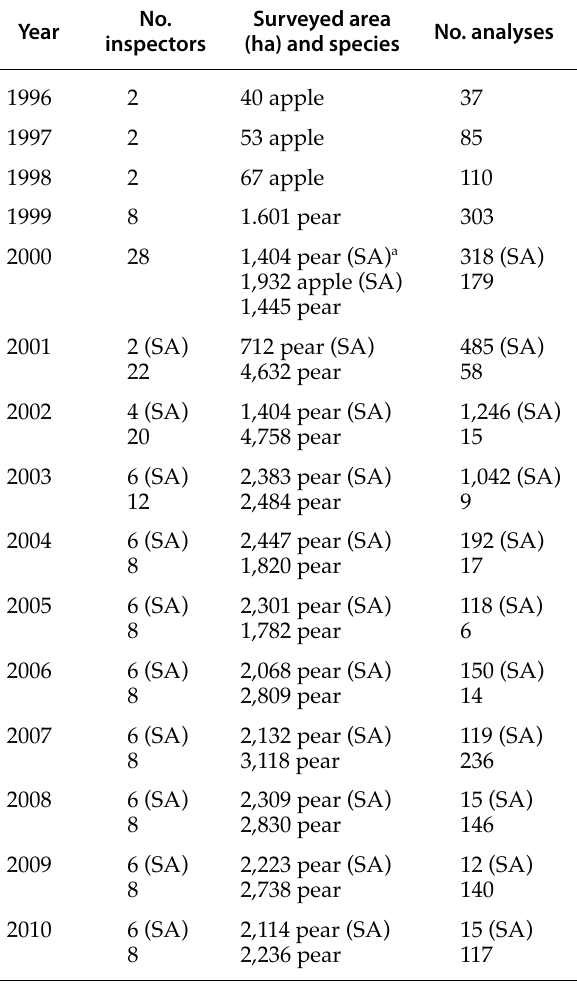
Table 1. Fire blight surveys and sample analyses performed in Aragón (Spain).